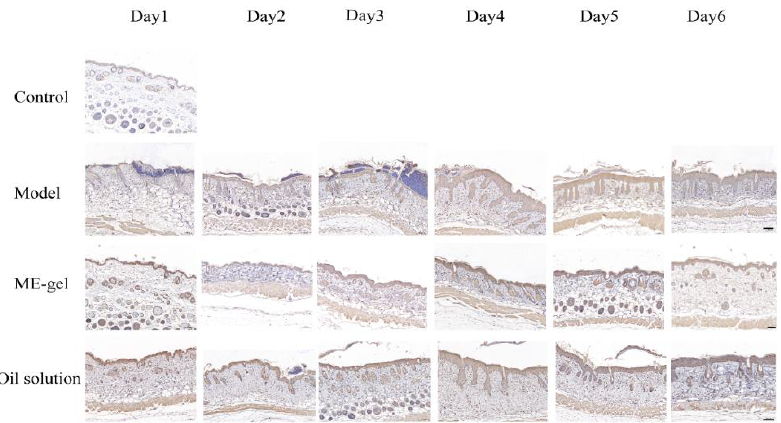
Figure 9. Effects of IR on the expression of IL-17 on the back skin of psoriatic mice (magnification 100×; scale bar 100 µm).